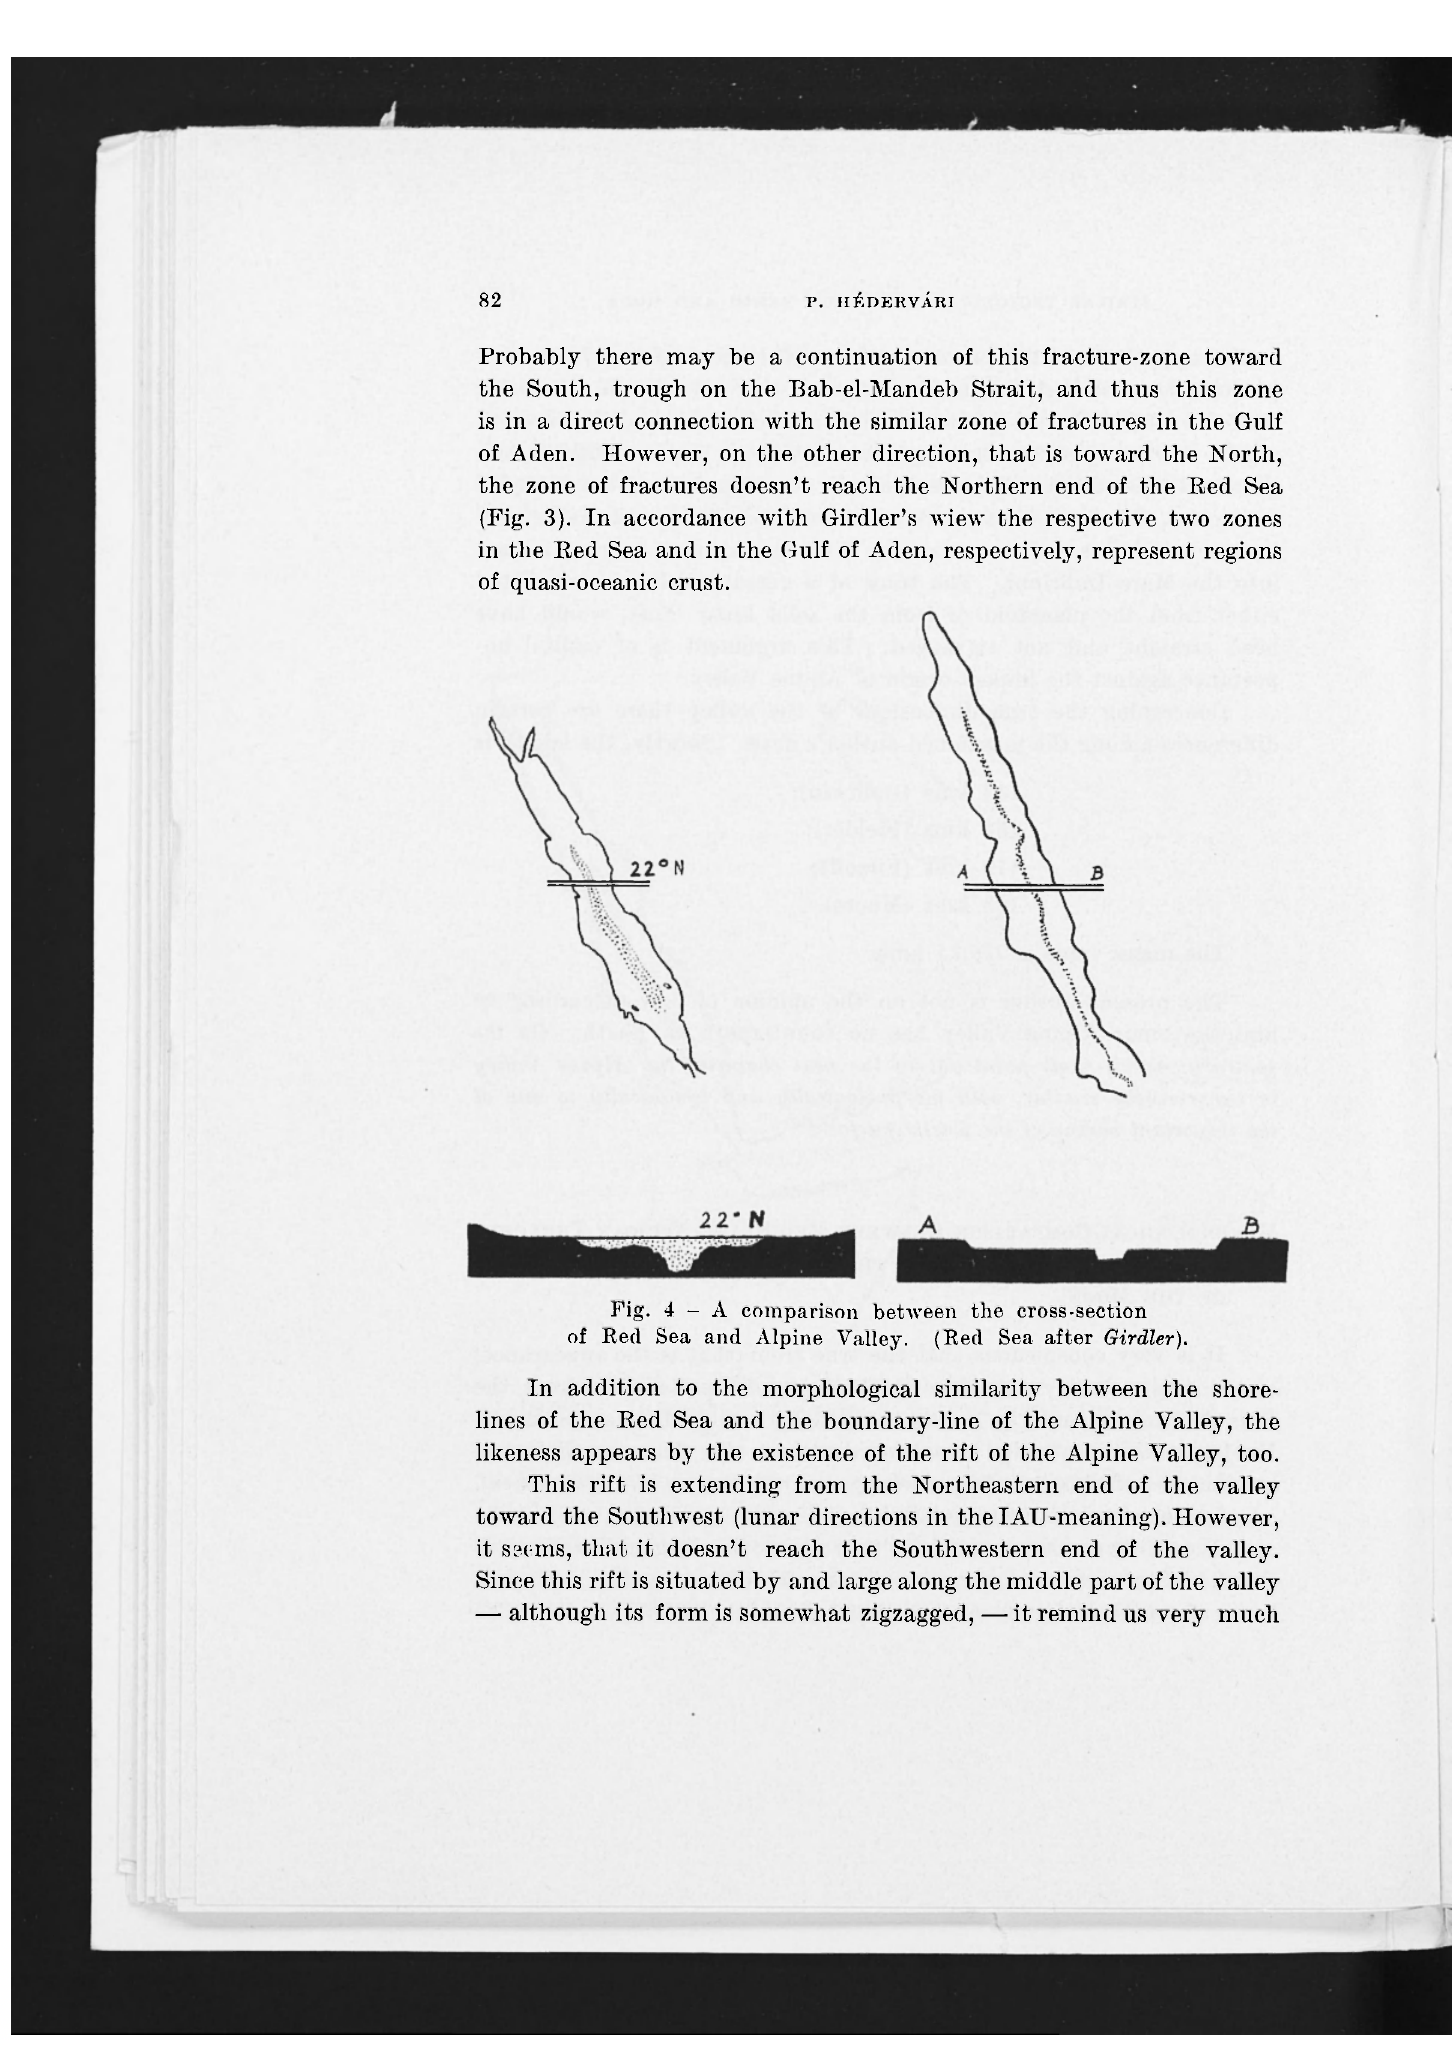
Fig. 4 - A comparison between the cross-section of Red Sea and Alpine Valley. (Red Sea after